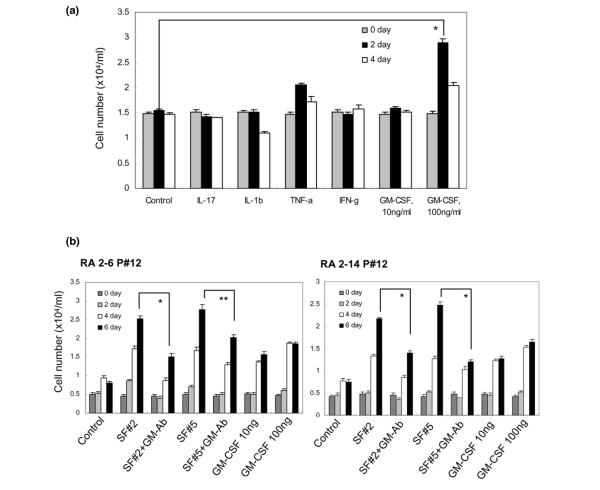
Effects of GM-CSF and cytokines on the growth of high-passage-number RA FLSs. (a) Rheumatoid arthritis (RA) fibroblast-like synoviocytes (FLSs) 2–14 (at passage 11) were seeded at 1.5 × 104 cells per well in triplicate in a 24-well plate. Cells cultured in high-glucose DMEM supplemented with 10% FBS were treated with cytokines (each at 100 ng/ml) or 10 or 100 ng/ml granulocyte – macrophage colony-stimulating factor (GM-CSF) on day 0. Cells were harvested every 2 days and counted. (b) The growth restoration of RA FLSs mediated by synovial fluid (SF) was markedly inhibited by neutralizing antibody against GM-CSF. RA FLSs (2–6 and 2–14) at passage 12 were cultured at 5 × 103 cells per well in a 24-well plate. FLSs in culture were treated with GM-CSF (10 or 100 ng/ml) or SF at 1/10 dilution every 2 days for 6 days. SF-treated FLSs were cultured in the presence or absence of anti-GM-CSF neutralizing antibody (300 ng/ml). Cells were counted and assessed for viability by trypan blue staining every 2 days. The results are means ± SD obtained from single experiments performed in triplicate cultures. *p < 0.01; **p < 0.05.